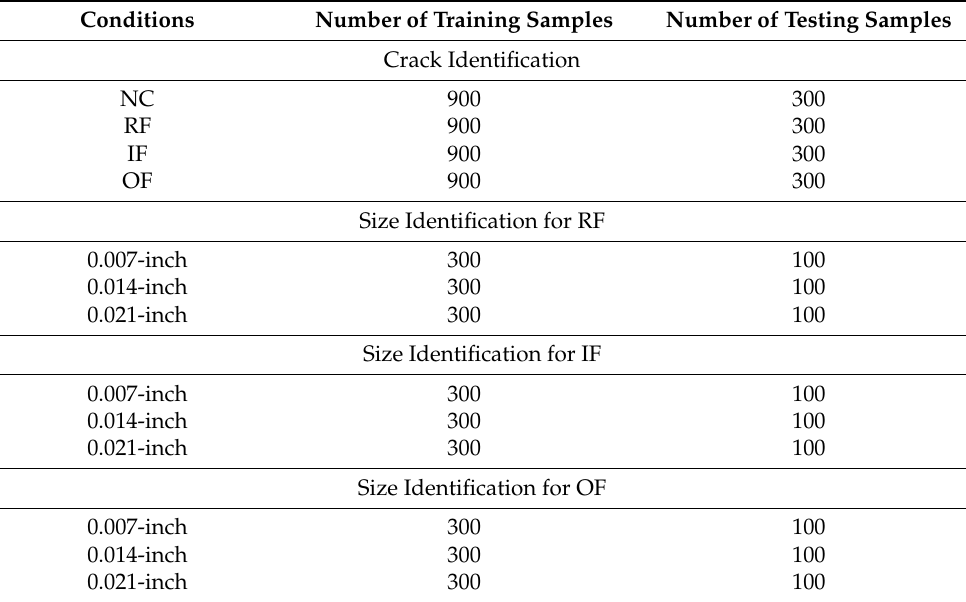
Table 3. Information regarding the training and testing for classification using the SVM. Conditions